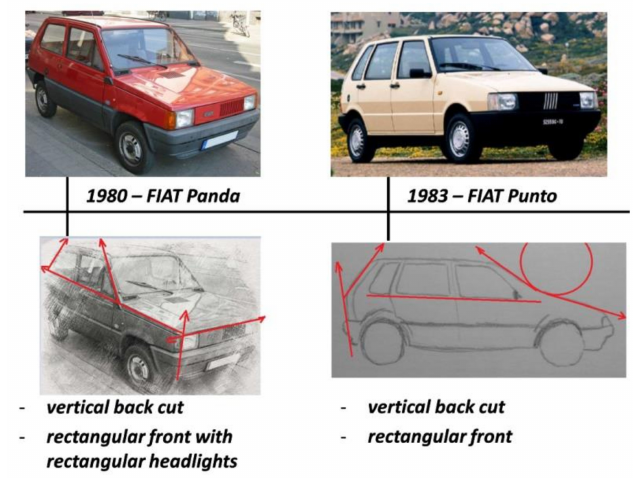
Figure 14. Stylistic evolution of FIAT car city models.